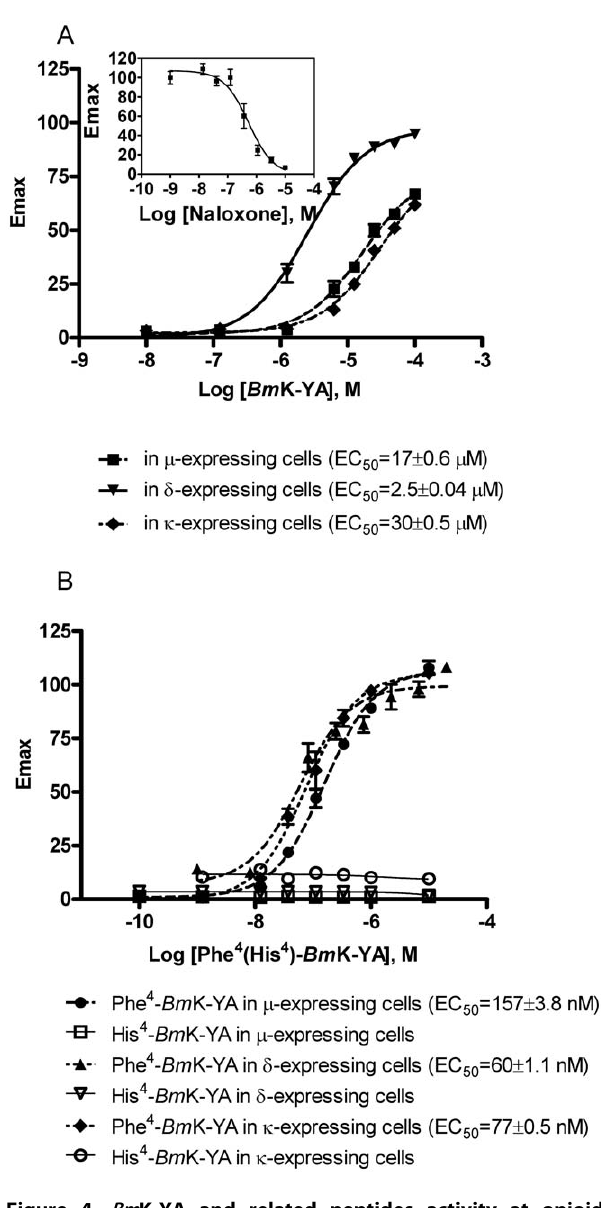
Figure 4. Bm K-YA and related peptides activity at opioid receptors. (A) Dose response curves of intracellular Ca 2 + mobilization induced by Bm K-YA in opioid receptors-expressing HEK293T cells. The EC 50 was 17 6 0.6 m M, 2.5 6 0.04 m M and 30 6 0.5 m M (mean 6 SE, n=3) in m -, d - and k -expressing HEK293T cells, respectively. The insert shows the inhibitory effect of naloxone on Bm K-YA-induced Ca 2 + release in d - expressing cells (IC 50 : 539 6 13 nM (mean 6 SE, n=3)); Bm K-YA concen- tration of used in this experiment was 2.5 m M. (B) Dose response curves of intracellular Ca 2 + mobilization induced by Phe 4 - Bm K-YA and His 4 - Bm K-YA in m -, d - and k -expressing HEK293T cells, respectively. The EC 50 of Phe 4 - Bm K-YA was 157 6 3.8 nM, 60 6 1.1 nM, and 77 6 0.5 nM (mean 6 SE, n=3) in m -, d - and k -expressing HEK293T cells, respectively.